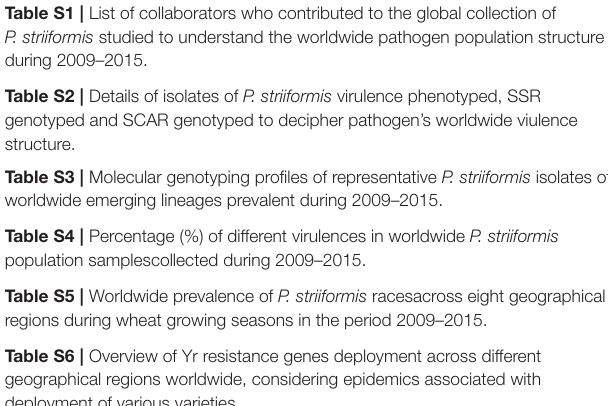
Table S1 | List of collaborators who contributed to the global collection of P. striiformis studied to understand the worldwide pathogen population structure during 2009–2015. Table S2 | Details of isolates of P. striiformis virulence phenotyped, SSR genotyped and SCAR genotyped to decipher pathogen’s worldwide viulence structure.